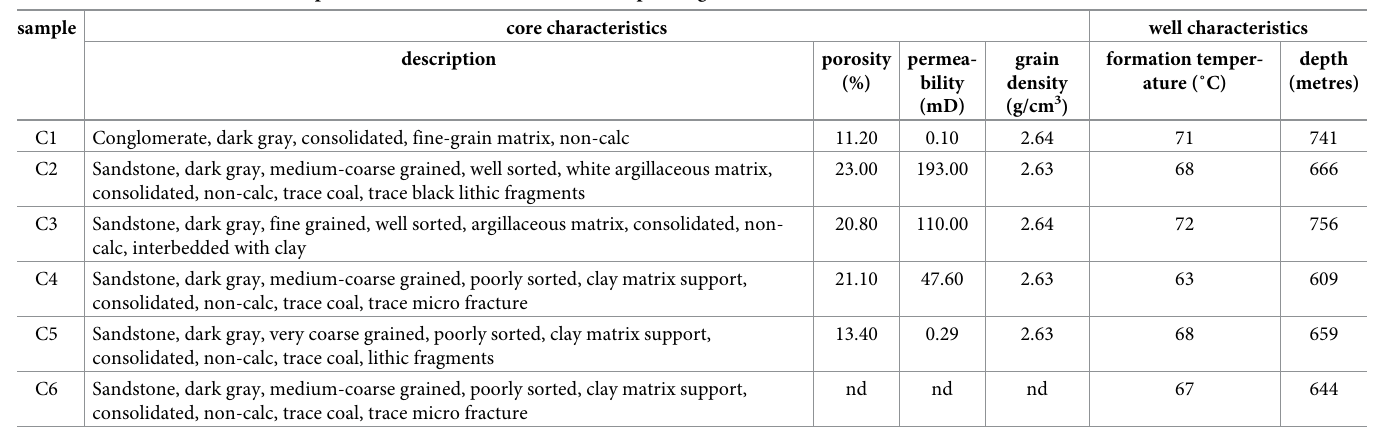
Table 1. Characteristics of core samples and the wells from which core samples originated.